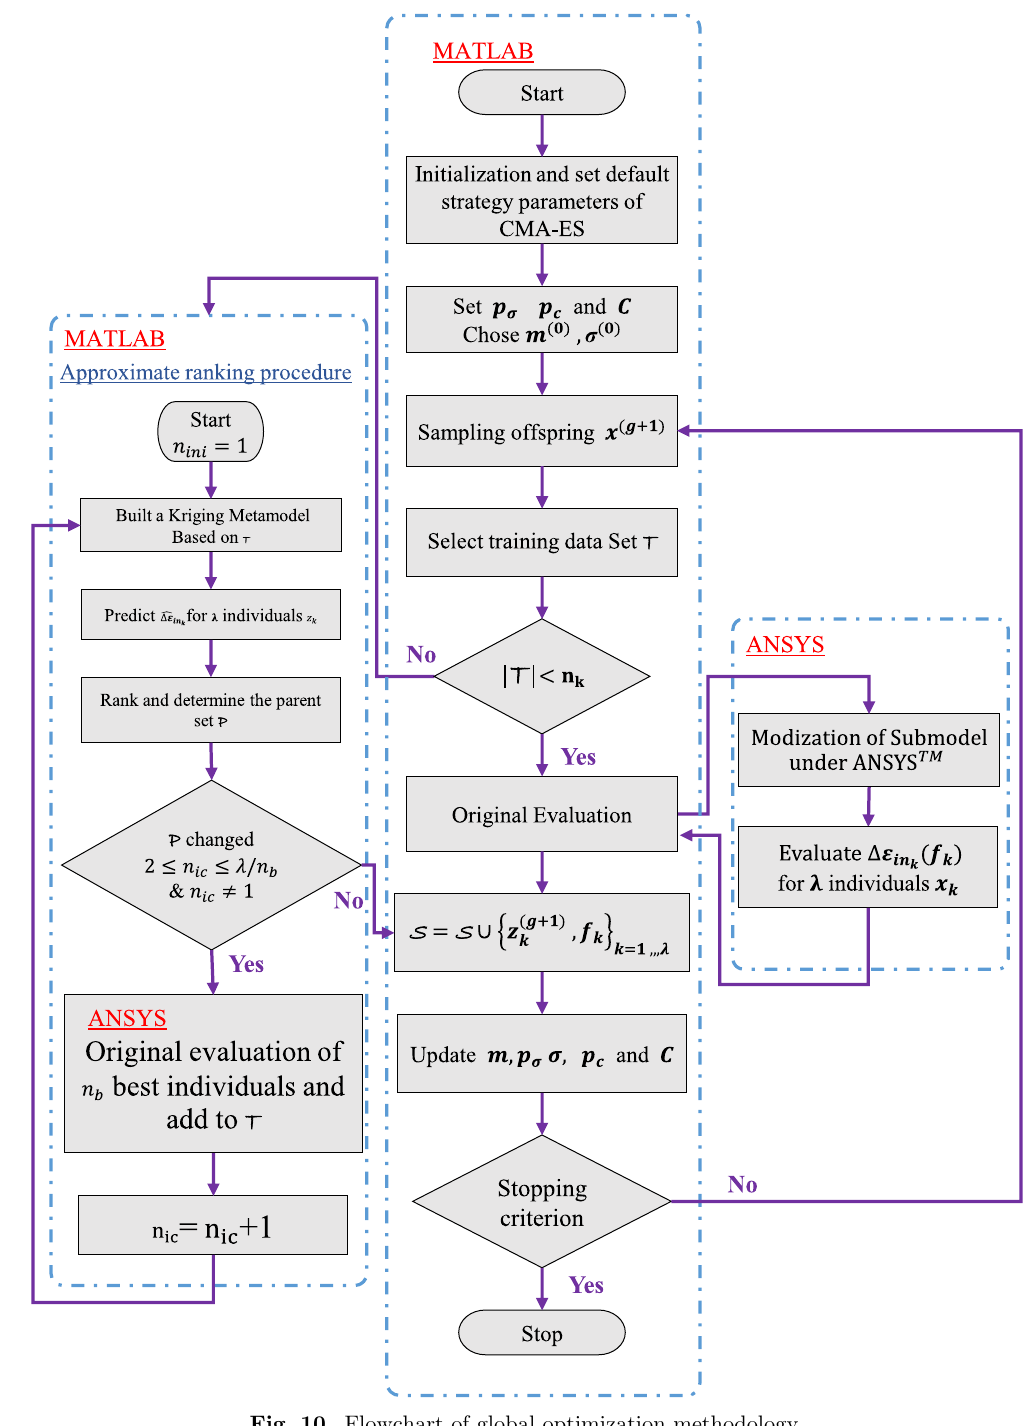
Fig. 10. Flowchart of global optimization